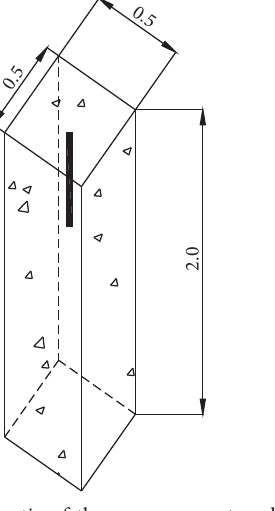
Figure 5: Schematic of the survey peg at each point.